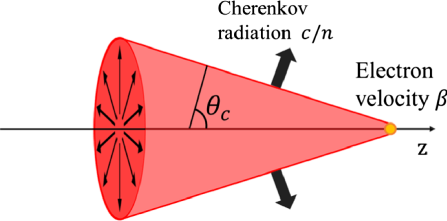
FIG. 1. Diagram of Cherenkov radiation. When a charged particle travels with a velocity β exceeding the velocity of light in a medium c=n , Cherenkov radiation is generated in the form of a cone with the particle ’ s orbit as its axis.